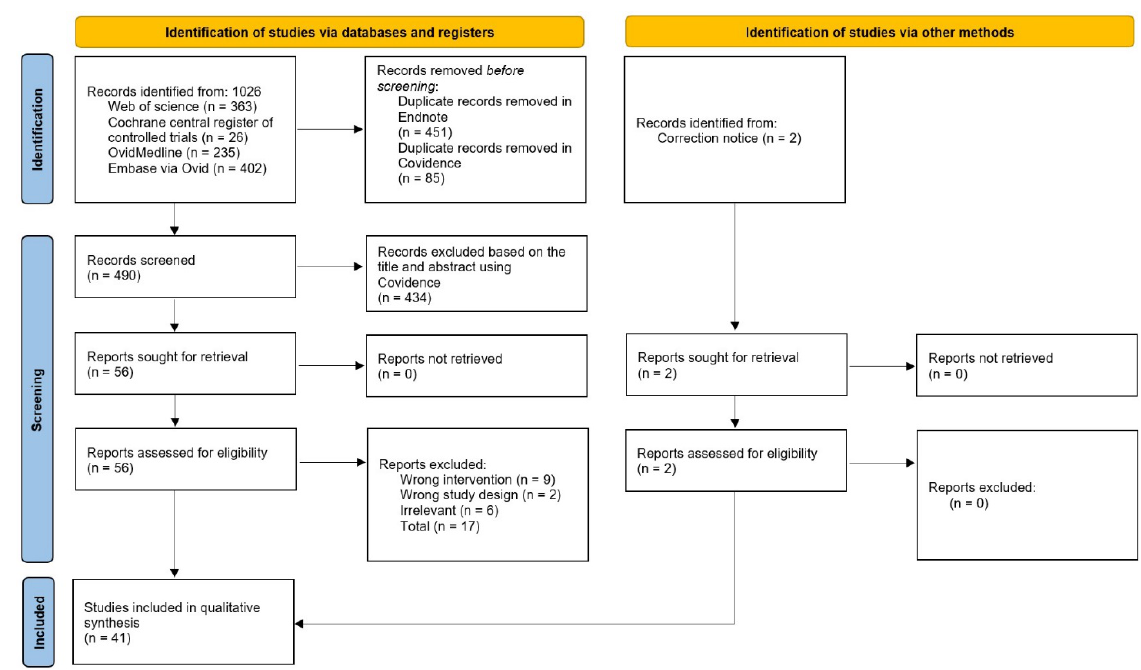
Figure 1. PRISMA flow diagram for the article selection process.